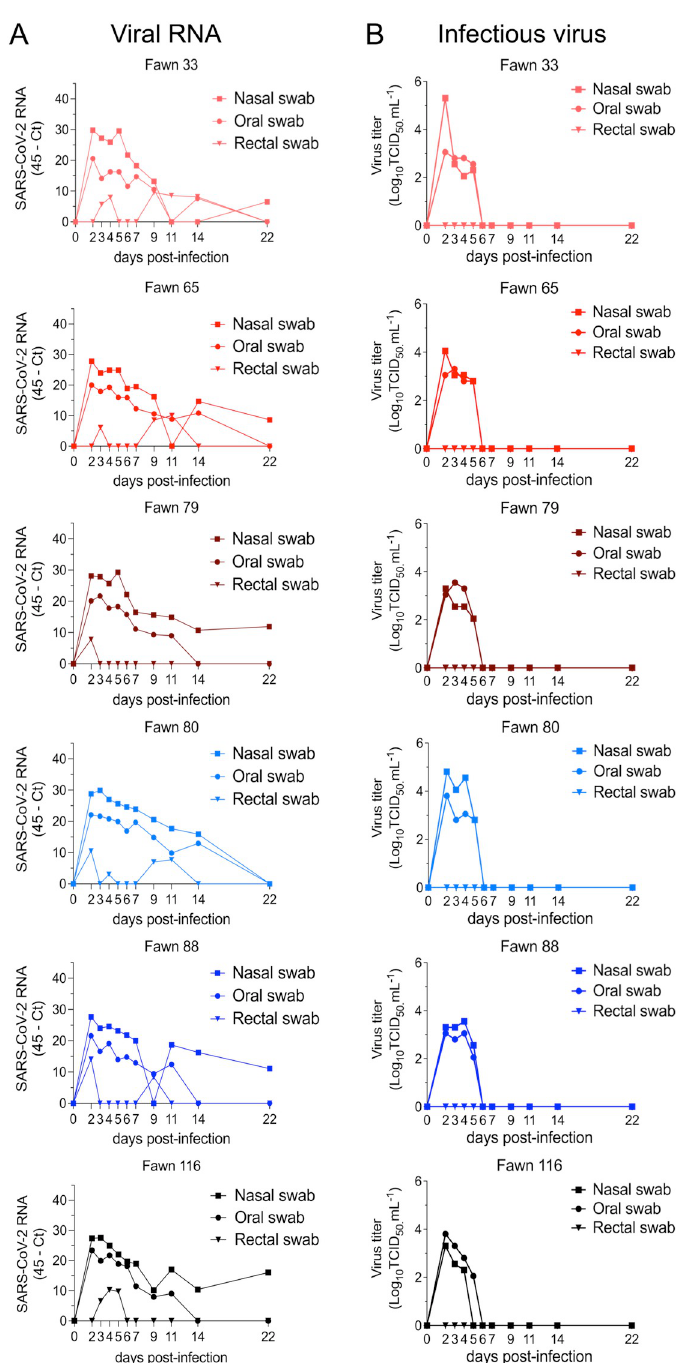
Fig 2. Viral shedding dynamics in nasal and oral secretions and feces following SARS-CoV-2 inoculation in white- tailed deer. A ) SARS-CoV-2 RNA load assessed in nasal and oral secretions and feces of controls (animals no. 34, 67, 84, no shown) and six inoculated fawns (animals no. 33, 65, 79, 80, 88, and 116). Nasal, oral and rectal swabs collected on days 0, 2–7, 9, 11, 14, and 22 post-inoculation (pi) were tested for the presence of SARS-CoV-2 RNA by real-time reverse transcriptase PCR (rRT-PCR). B ) Infectious SARS-CoV-2 load in nasal and oral secretions and feces was assessed by virus titration in RT-rPCR-positive samples. Virus titers were determined using end point dilutions and expressed as TCID 50 .ml -1 . All the controls fawns (uninoculated) remained negative through the experimental period.